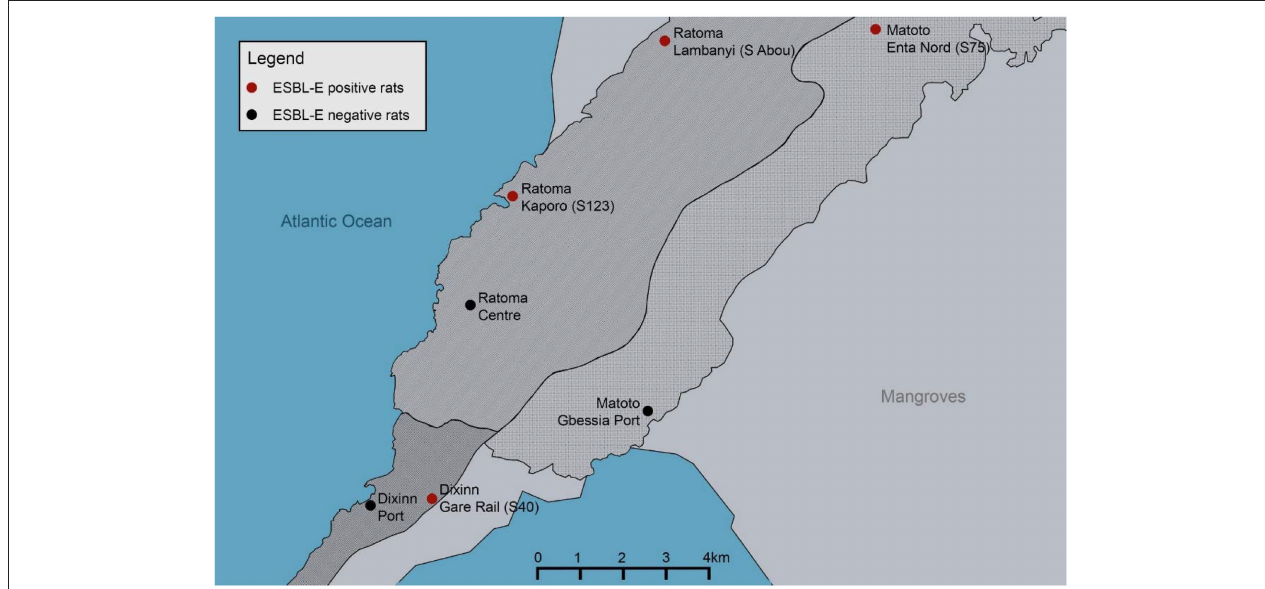
FIGURE 1 | Map of Conakry (Guinea, West Africa) marked in red are ESBL-E-positive rat trapping sites, marked in black are ESBL-E-negative rat trapping sites. Red: S40 (Dixinn Gare Rail: 1 positive out of 9 trapped animals [1/9]), S123 (Ratoma Kaporo: 1/10), S75 (Matoto Enta Nord: 2/4), S Abou (Ratoma Lambanyi: 2/2). Black: Dixinn Port (0/2) Matoto Gbessia Port (0/1) Ratoma Centre (0/1).